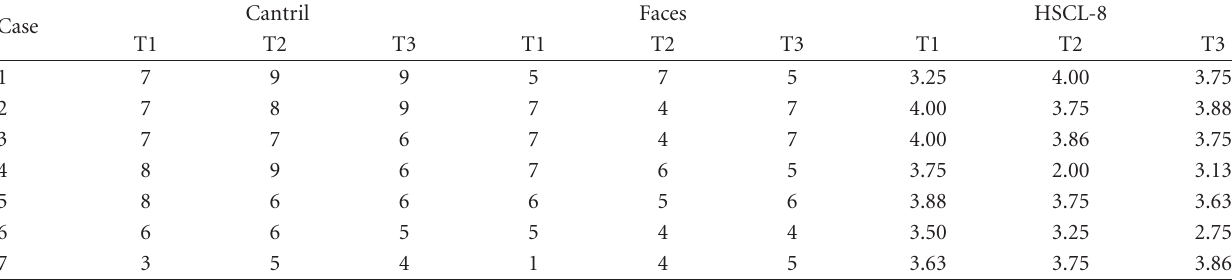
Table 4: The participants’ statements on the Cantril, Faces, and HSCL instruments.